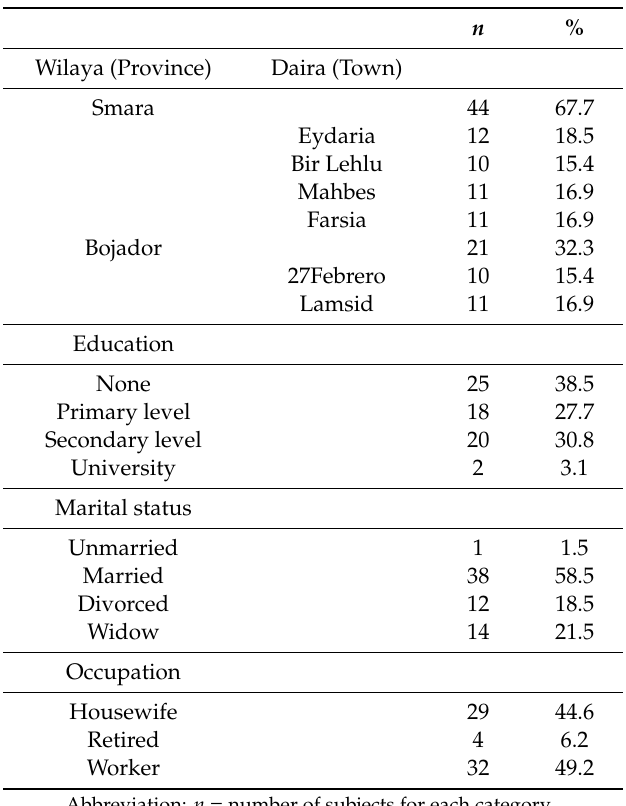
Abbreviation: n = number of subjects for each